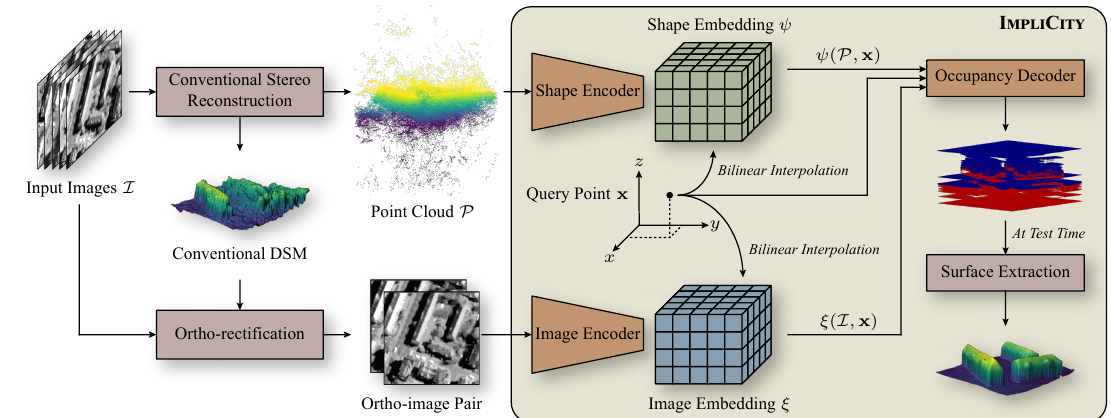
Figure 2. Method overview. Satellite images are processed into a 3D point cloud and a coarse DSM as a basis for ortho-rectification (left side). I MPLI C ITY takes the point cloud and ortho-photos as input and transforms them into a shape embedding ψ and an image embedding ξ , which can be decoded into occupancy values in continuous 3D space to recover a high-accuracy